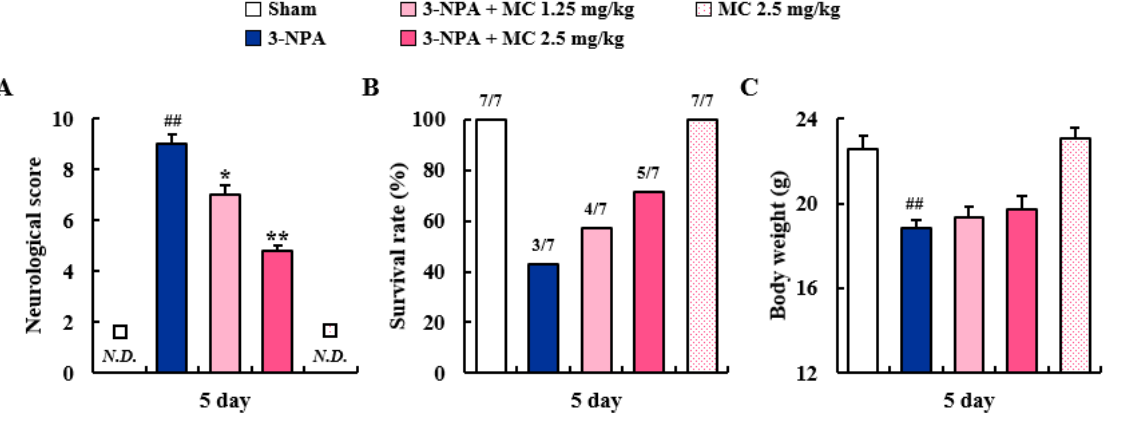
Figure 1. MC alleviates neurological dysfunction and improves survival rate after 3-NPA treatment. ( A – C ) Effects of MC on neurological score (motor disability), survival rate, and BW during 3-NPA treatment period. MC was intravenously treated once daily for 5 days 1 h before 3-NPA treatment. At 24 h after the last (5th) 3-NPA treatment, the neurological score ( A ), survival rate ( B ), and BW ( C ) of mice from sham ( n = 7), 3-NPA ( n = 7), 3-NPA + MC (1.25 mg/kg/day; n = 7), 3-NPA + MC (2.5 mg/kg/day; n = 7) and MC (2.5 mg/kg/day; n = 7) groups were measured. For the neurological score, levels of global activity, hindlimb clasping, hindlimb dystonia, truncal dystonia, and balance adjustment to a postural challenge were measured and their values were combined. N.D., not detected. In graph B, the values above the bars represent survival rates (number of surviving animals/number of total animals). Data are expressed as mean ± standard error of the mean (SEM) (Kruskal–Wallis; ## p < 0.01 versus sham group; * p < 0.05 and ** p < 0.01 versus 3-NPA group).